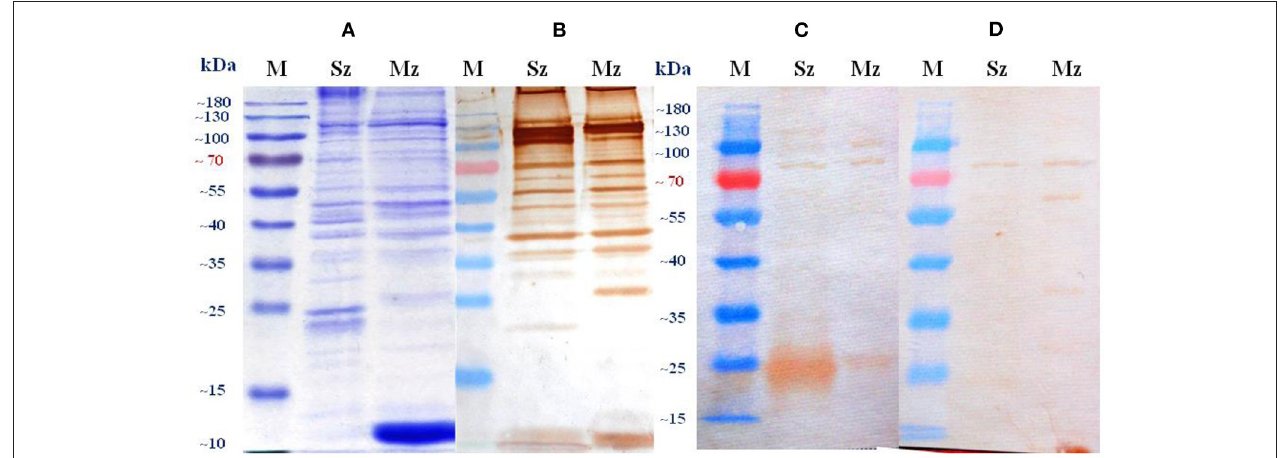
FIGURE 5 | Sporozoite (Sz) and merozoite (Mz) proteins of a wild-type E. tenella strain resolved by SDS-PAGE on a 12% gel and stained by Coomassie brilliant blue (A) or probed in immunoblots with pooled antiserum from birds orally (naturally) immunized with sporulated oocysts of E. tenella (B) , polyclonal egg yolk IgYs from birds immunized with whole E. tenella sporozoites (C) , and polyclonal egg yolk IgYs from birds immunized against Eimeria sp. (Supracox ® ) (D) . Sera from unimmunized SPF White Leghorn birds did not show evidence of reactivity (data not shown). The pooled antiserum was diluted 1:100 in (B) and the egg yolk IgYs suspension was diluted 1:25 in (C, D) . M stands for protein standard.